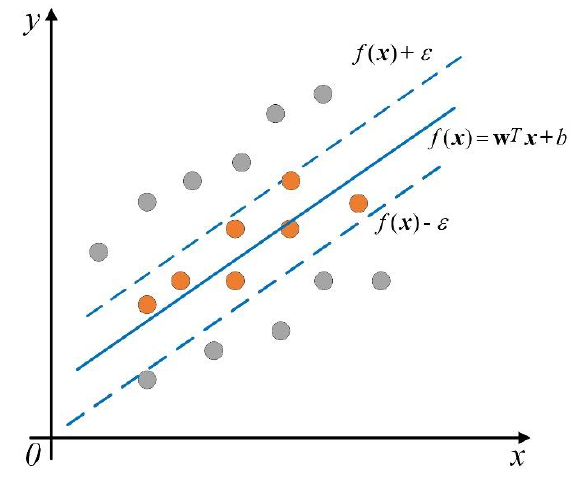
Figure 1. The schematic diagram of support vector regression (SVR).